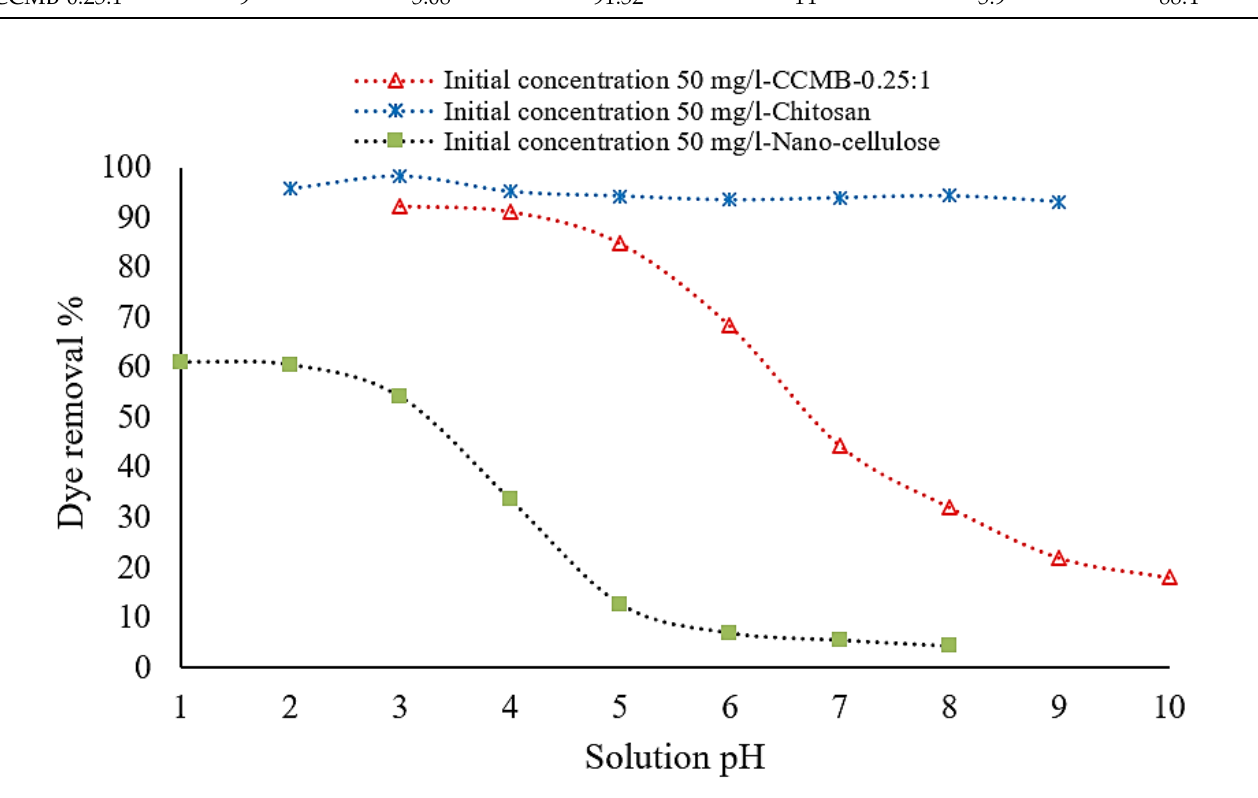
Figure 13. Effect of pH value on DB78 dye removal efficiency (temperature of 22 °C, pH of 1 – 10, and mixing speed of 150 r.p.m.).